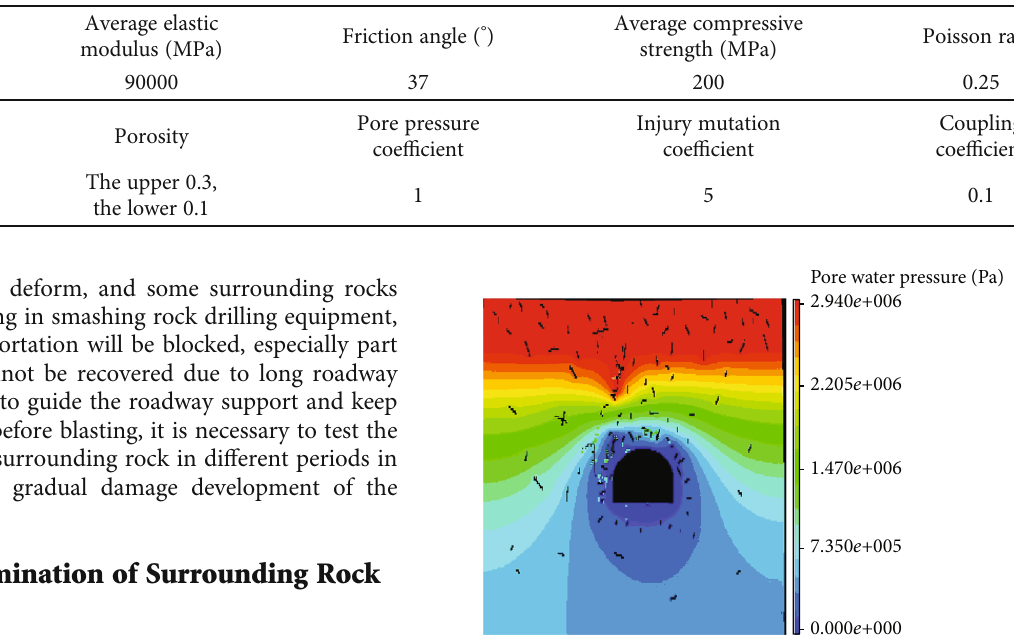
Table 1: Mechanical parameters of the calculation model for the seepage tunnel.